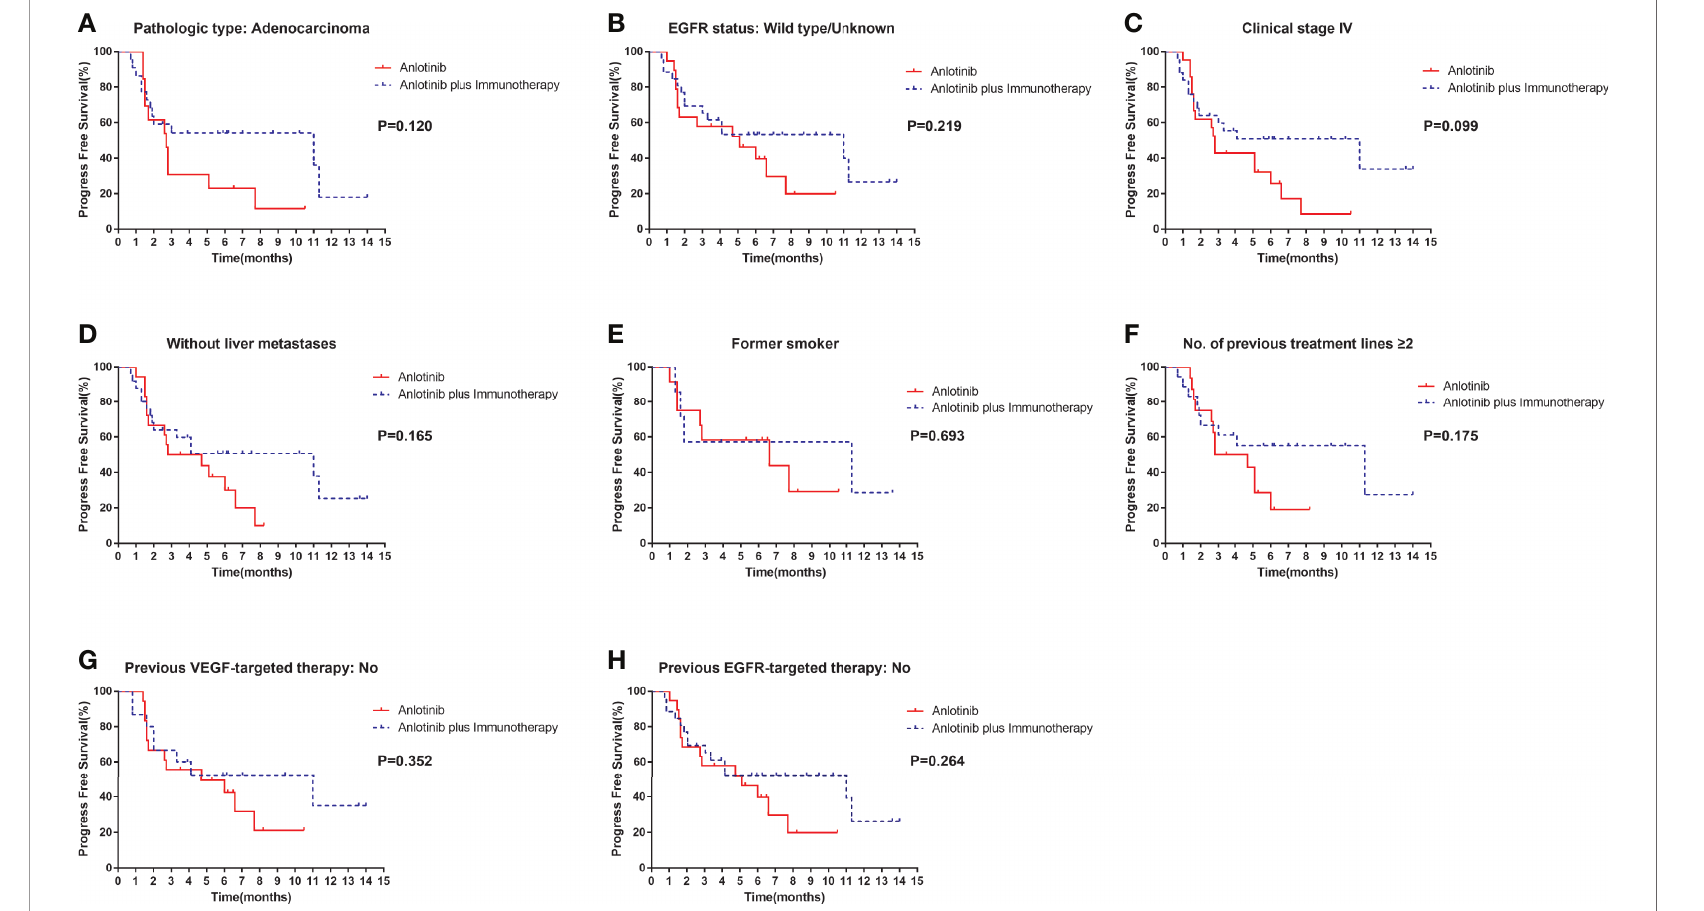
FIGURE 4 | Strati fi cation analysis of PFS between patients in the anlotinib arm and anlotinib plus immunotherapy arm. (A) strati fi ed by pathologic type: Adenocarcinoma; (B) strati fi ed by EGFR status: Wild type/ Unknown; (C) strati fi ed by clinical stage IV; (D) strati fi ed by without liver metastases; (E) strati fi ed by former smoker; (F) strati fi ed by No. of previous treatment lines ≥ 2; (G) strati fi ed by previous VEGF-targeted therapy: No; (H) strati fi ed by previous EGFR-targeted therapy: